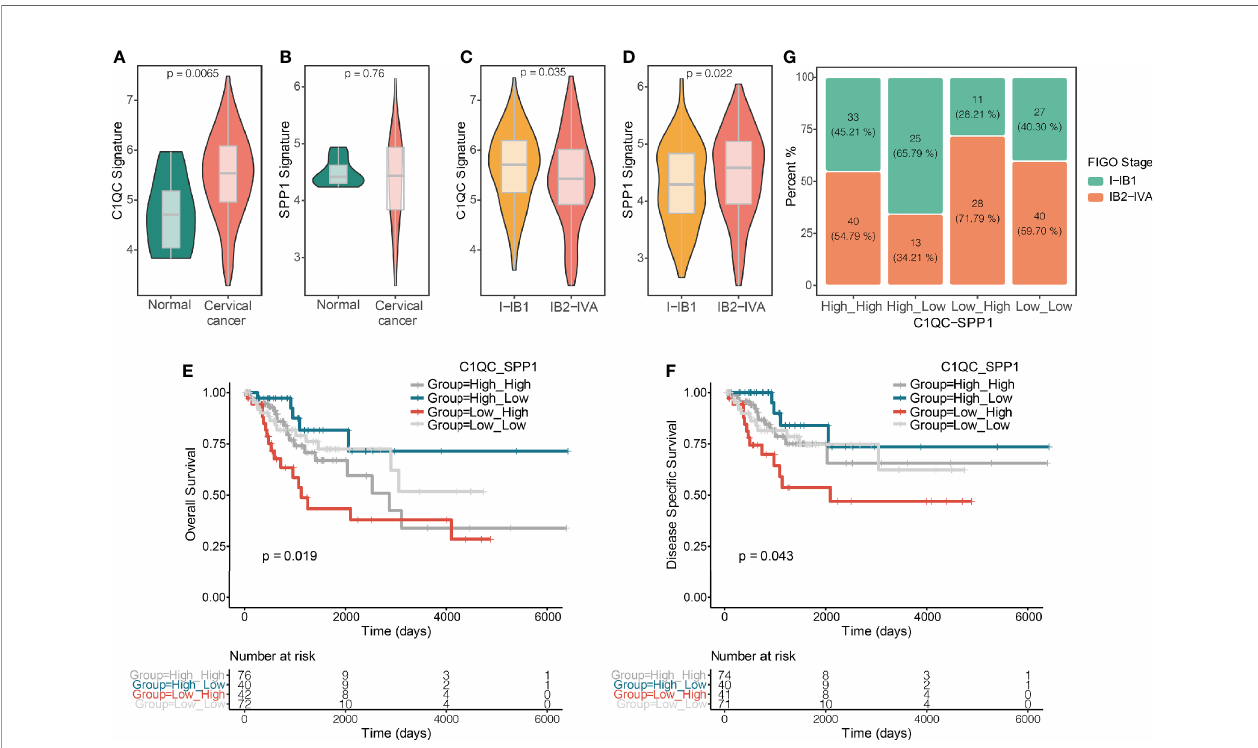
FIGURE 2 | C1QC+ and SPP1+ TAMs gene signatures in TCGA cervical cancer patients. (A) Violin plots showing comparison of C1QC + TAM gene signatures levels between normal and cervical cancer samples in TCGA. Two-sided Wilcoxon test. (B) Violin plots showing comparison of SPP1 + TAM gene signatures levels between normal and cervical cancer samples in TCGA. Two-sided Wilcoxon test. (C) Violin plots showing comparison of C1QC + TAM gene signatures levels between patients with FIGO stage 1-IB1 and patients with FIGO stage IB2-IVA in TCGA. Two-sided Wilcoxon test. (D) Violin plots showing comparison of SPP1 + TAM gene signatures levels between patients with FIGO stage 1-IB1 and patients with FIGO stage IB2-IVA in TCGA. Two-sided Wilcoxon test. (E) The Kaplan-Meier overall survival curves of TCGA cervical cancer patients grouped by the gene signature expression of C1QC + TAM and SPP1 + TAM. (F) The Kaplan-Meier Disease speci fi c survival curves of TCGA cervical cancer patients grouped by the gene signature expression of C1QC + TAM and SPP1 + TAM. (G) Proportions of patients with FIGO stage I-IB1 and IB2-IVA in cervical cancer patients grouped by the gene signature expression of C1QC + TAM and SPP1 +